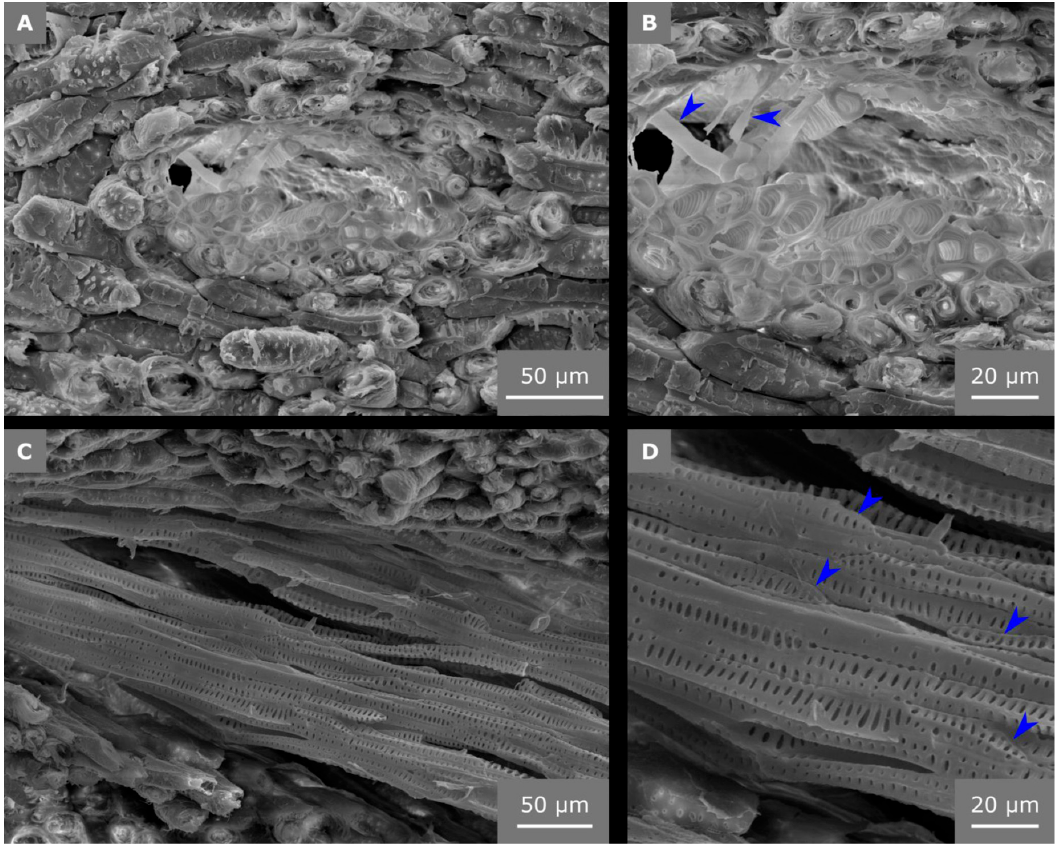
Figure 5. Comparison of the width-to-length ratio of the sclereid cells along the endocarp cross section. It was observed that the width-to-length ratio decreased significantly from the mesocarp side to the testa side (one-way analysis of variance, F (2177) = 68.91, p < 0.001 (***), Tukey HSD post-hoc testing).